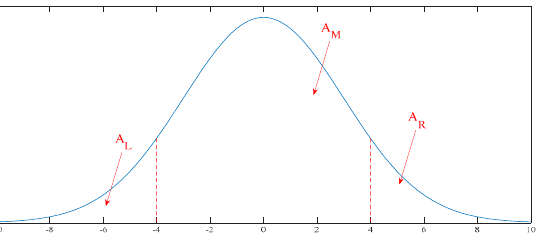
Figure 1. Sample for 20/60/20: area left (A L ), area middle (A M ), and area right (A R ) corresponding to 20%, 60%, and 20%, respectively.